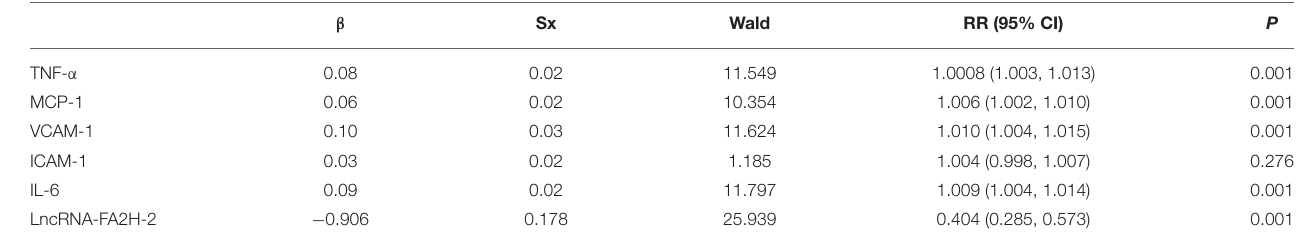
TABLE 12 | Binary logistic regression analysis of CHD